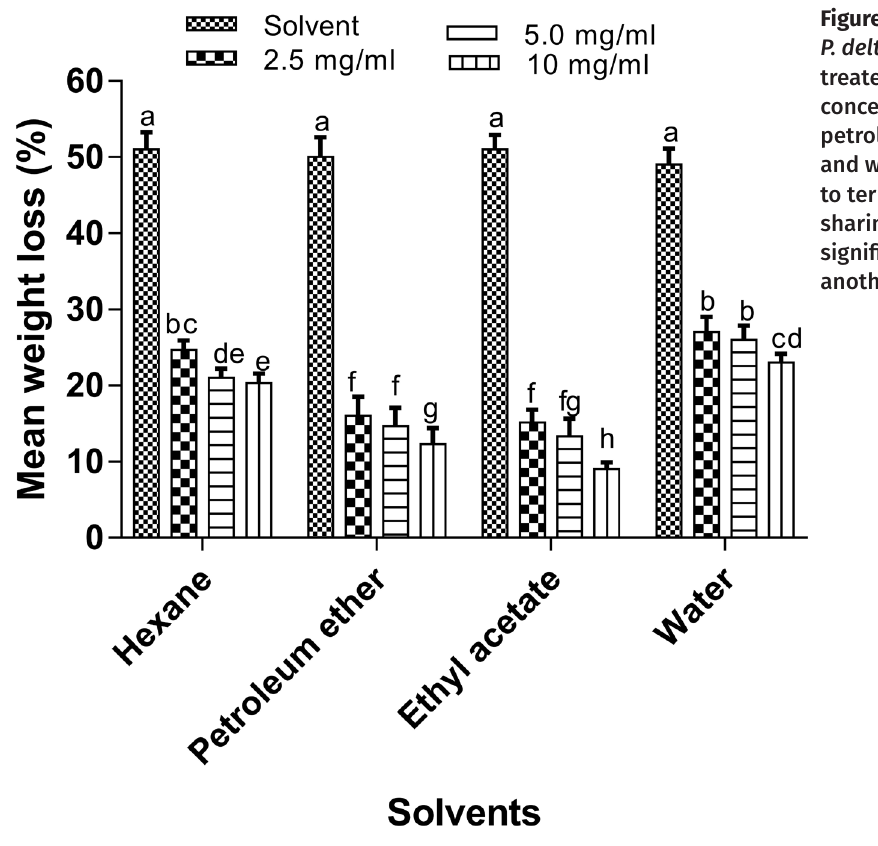
Figure 5. Mean weight loss of P. deltoides stakes pressure treated with different concentrations of n-Hexane, petroleum ether, ethyl acetate, and water extracts and exposed to termites in the field. Means sharing different letters are significantly different from one another. F=49.39,